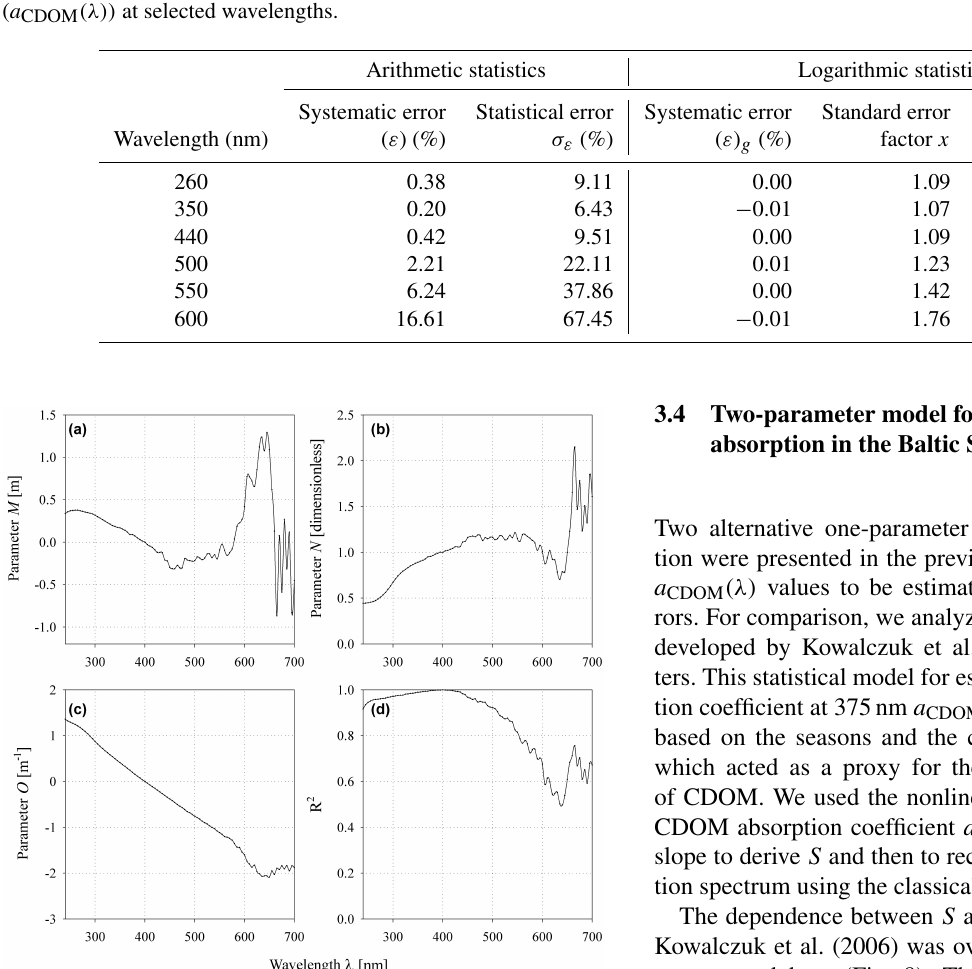
Table 4. Relative errors of the empirical model given by Eq. (14) for determining spectral values of CDOM absorption coefficients ( a CDOM (λ)) at selected wavelengths.